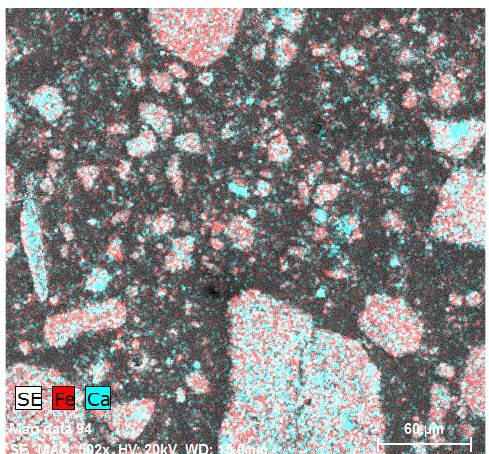
Figure 19. The EDX analysis of NS particles in the polymeric matrix—graphic illustration of the elements present.